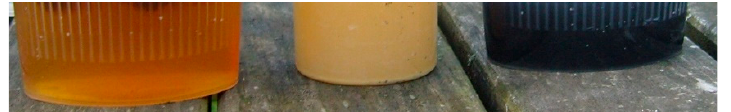
Figure 3. Example of n-Fe(b)@gallic acid polymer manufacture. Left container: dissolved gallic acid- polyphenol mixture (derived from black tea). Middle container: dissolved FeSO 4 . Right container (black color): entrained n-Fe(b)@gallic acid polymer (gel) in water, manufactured by adding the gallic acid to the dissolved FeSO 4 . The containers are resting on 10 cm wide wooden boards.